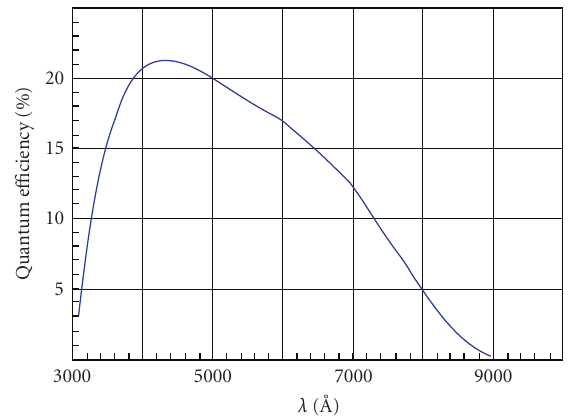
Figure 5: Spectral sensitivity curve of the multialkali (S20) photocathode employed in TORTORA.